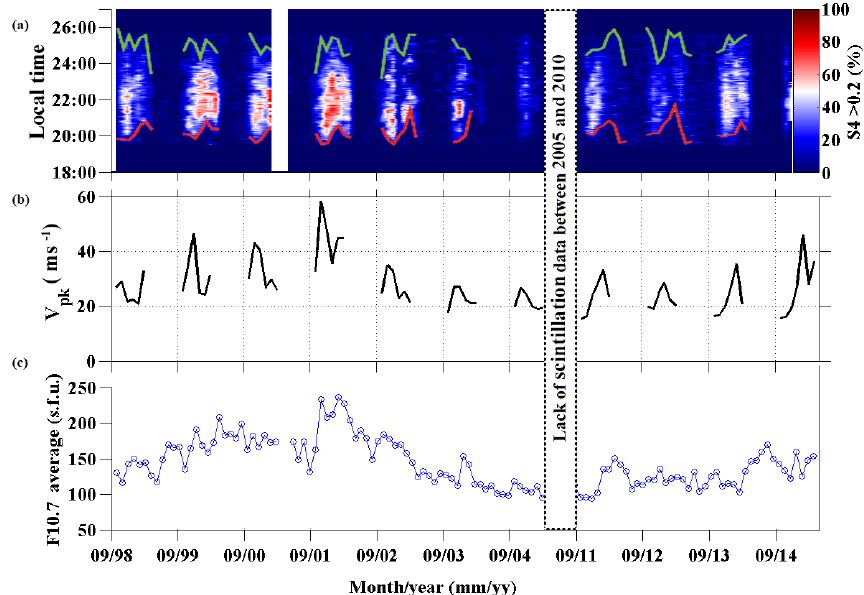
Figure 5. (a) Percentage of links affected by scintillation during September 1998–December 2014). (b) V pk values as calculated through monthly average given by SAMI2 model. (c) Solar F10.7 index average values for the period under